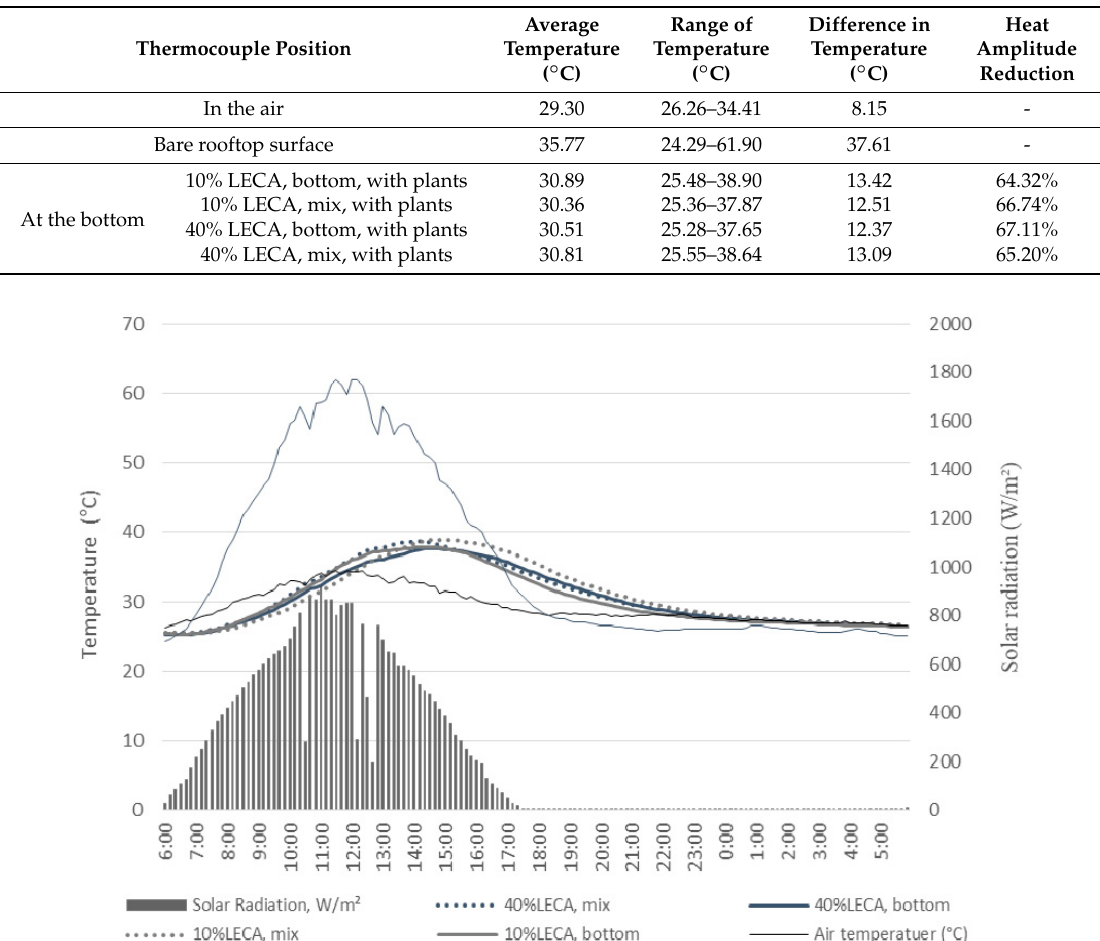
Figure 19. Temperatures and solar radiation in the cases of roofs with 10% and 40% LECA laid at the bottom with Ipomoea batata , and of 10% and 40% LECA mixed with the soil with Ipomoea batatas (1 October 2017 06:07:57 to 2 October 2017 05:57:57).